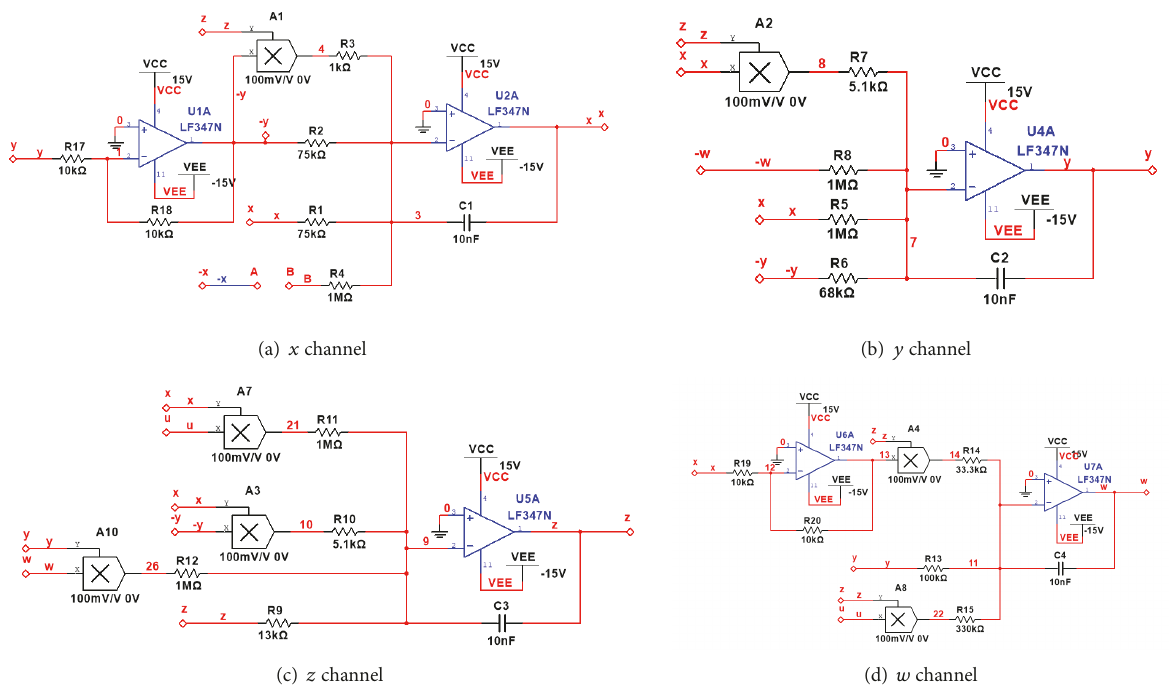
Figure 5: Modularized circuit channels for circuit implementation of the new memristor-based 5D hyperchaotic system.